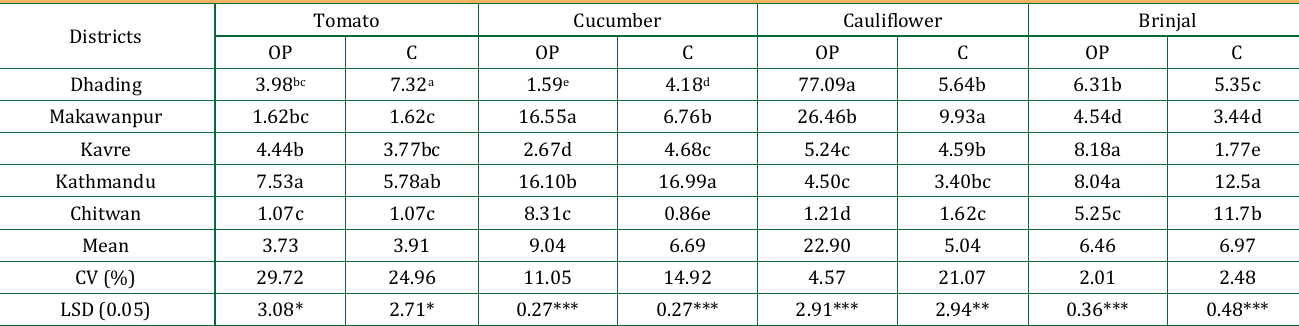
Table 2: Pesticides Inhibition Percentage (%) of Different Vegetables at Kalimati Market